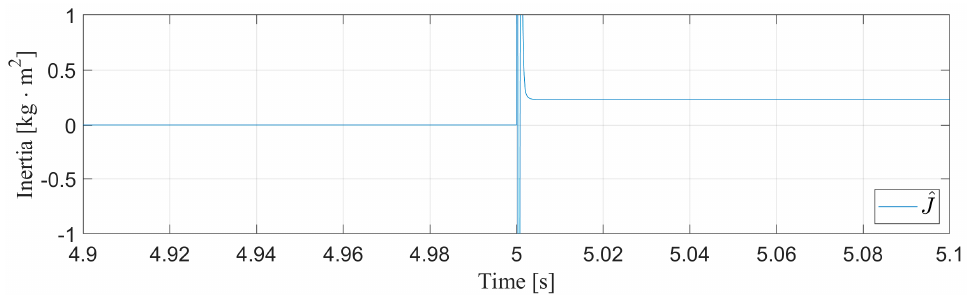
Figure 9. Adaptive inertia observer during wind step.